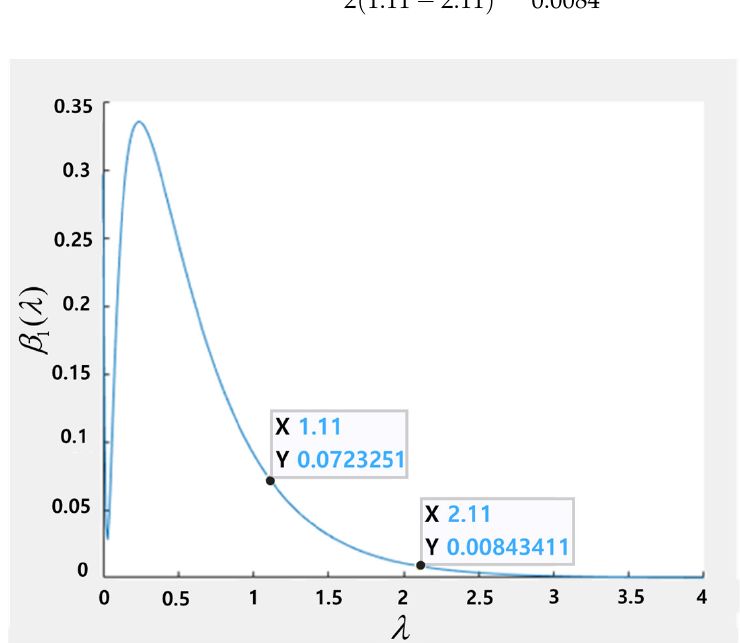
Figure 9. β  (λ) according to Equation (24). Figure 9. β 1 ( λ ) according to Equation